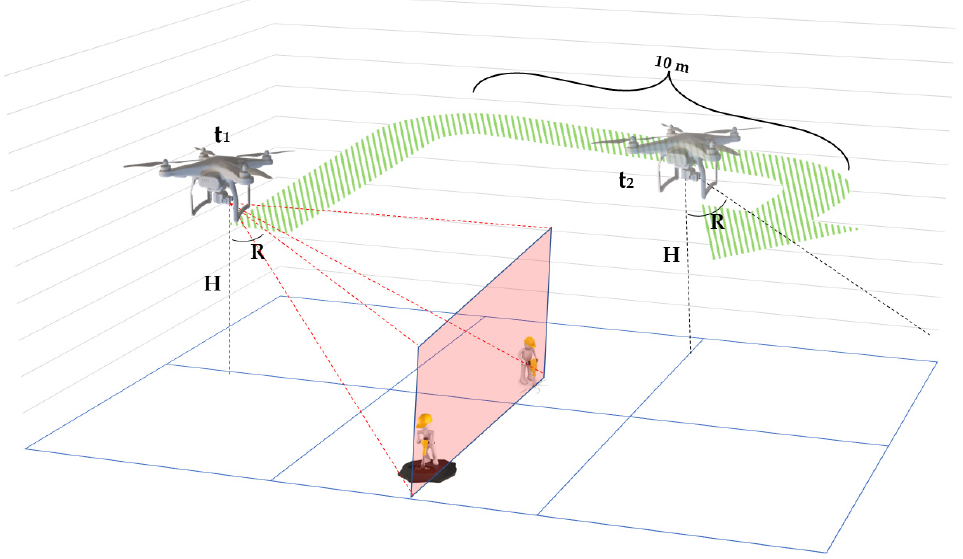
Figure 2. Experimental sites and data collection. ( a ) location of the test site, ( b ) UAV, wearable glasses, and operating stick, ( c ) an example of the UAV inspection path. ( d ) Example of UAV data.